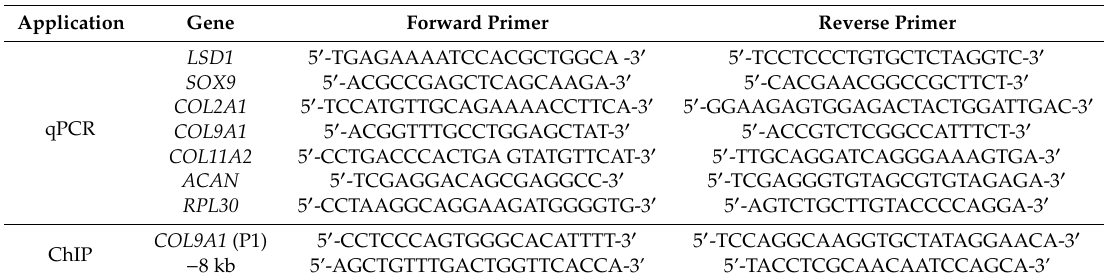
Table 1. List of primers used for PCR